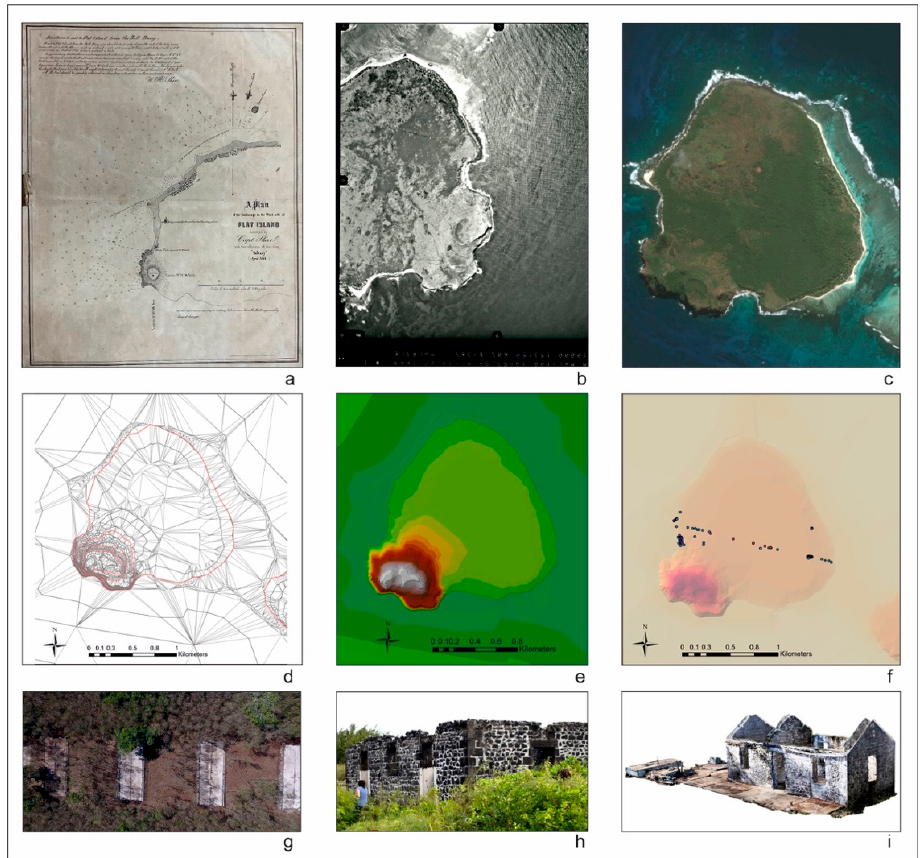
Figure 2. Research workflow: ( a ) historical map; ( b ) aerial image; ( c ) satellite image; ( d ) TIN model; ( e ) DEM model; ( f ) DEM model with GPS-RTK survey; ( g ) UAV image of Camp 1; ( h ) on-the-ground survey and clearing of baggage store (Str. 119); ( i ) 3D model of police station (Str. 122).